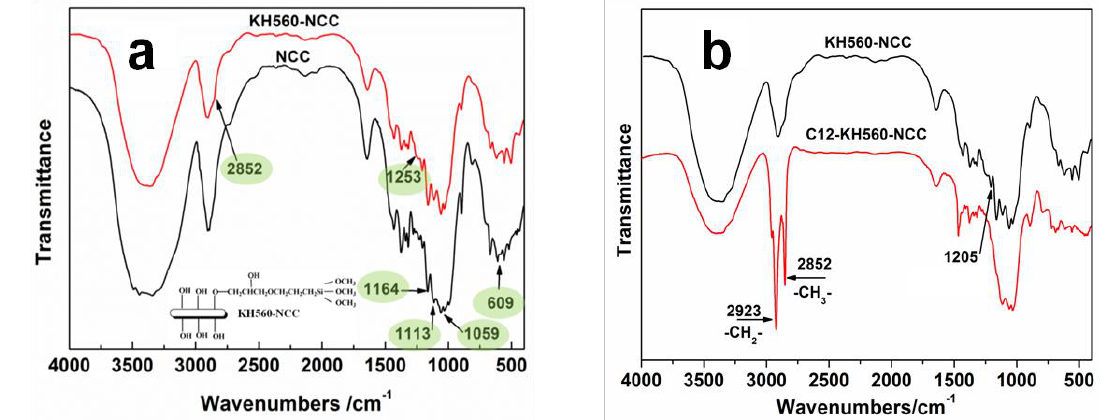
Figure 1. FTIR spectra of NCC and KH560-NCC ( a ), FTIR spectra of KH560-NCC and C12-KH560-NCC ( b ).